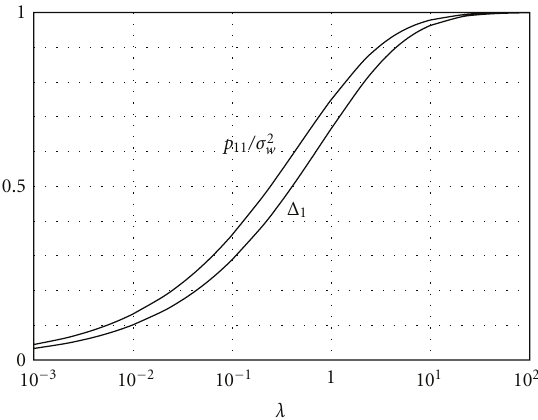
Figure 3: Noise ratios Δ 1 and p 11 /σ 2 w as functions of λ .